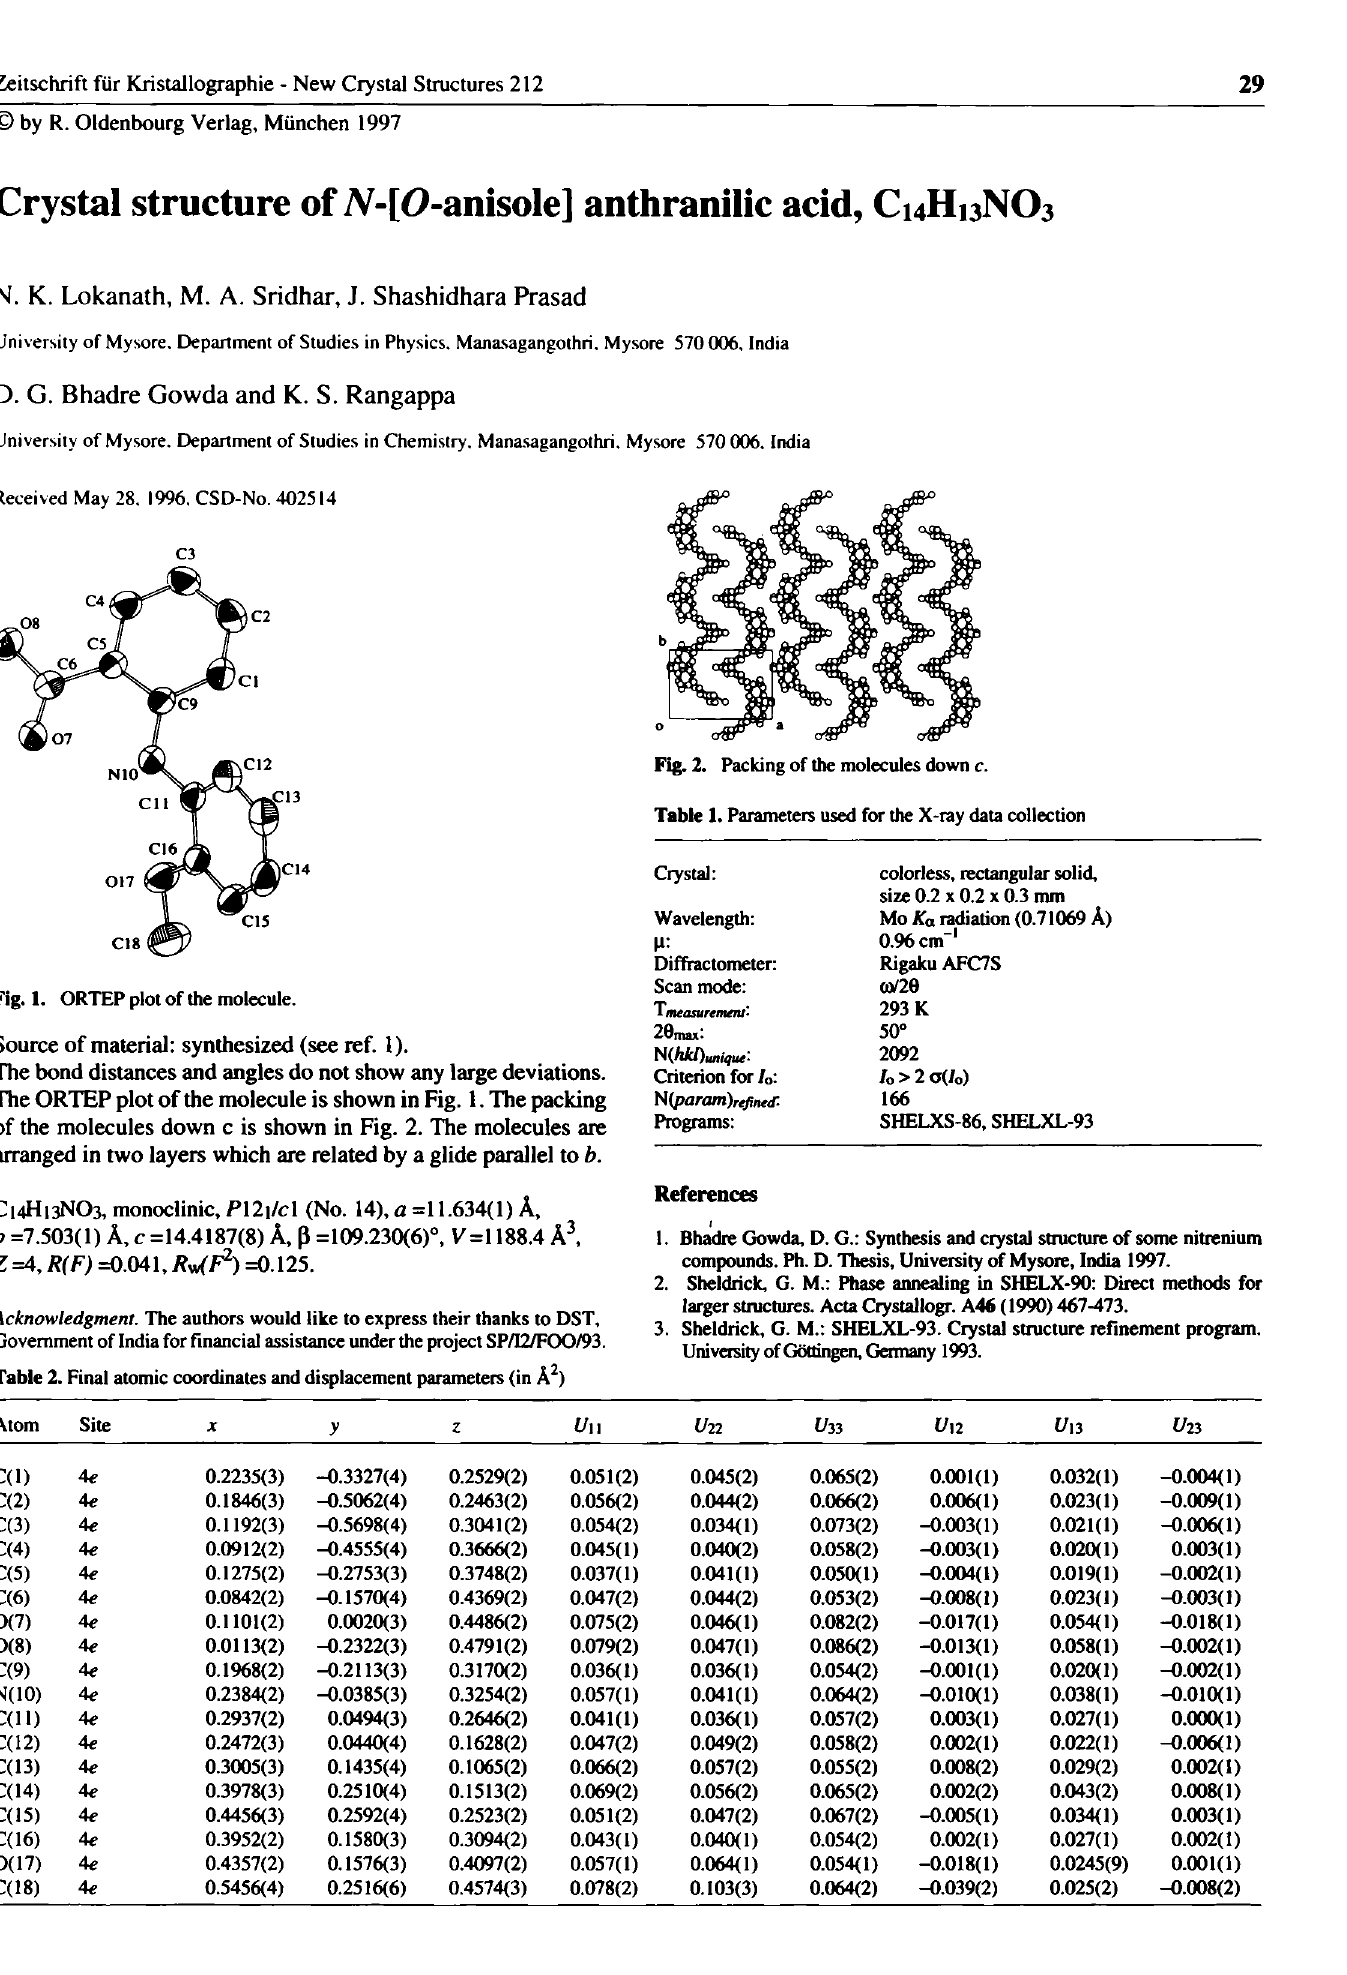
Fig. 2. Packing of the molecules down c. Table 1. Parameters used for the X-ray data collection